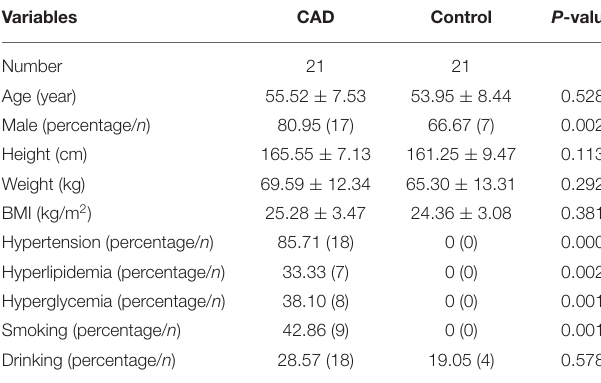
TABLE 1 | Base information and major cardiovascular risk factors in two